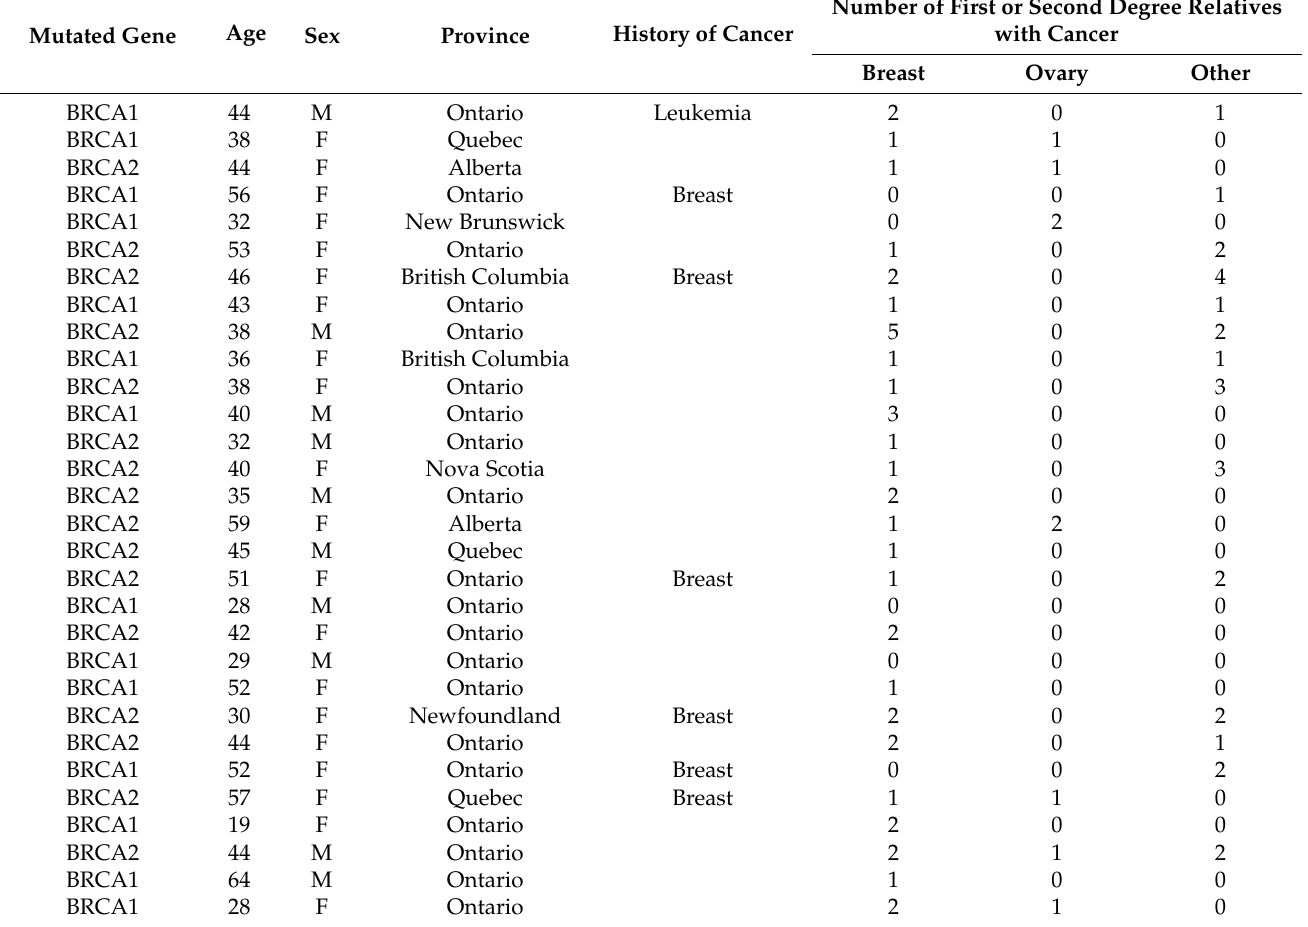
Table 3. Individuals with mutations identified in the Screen